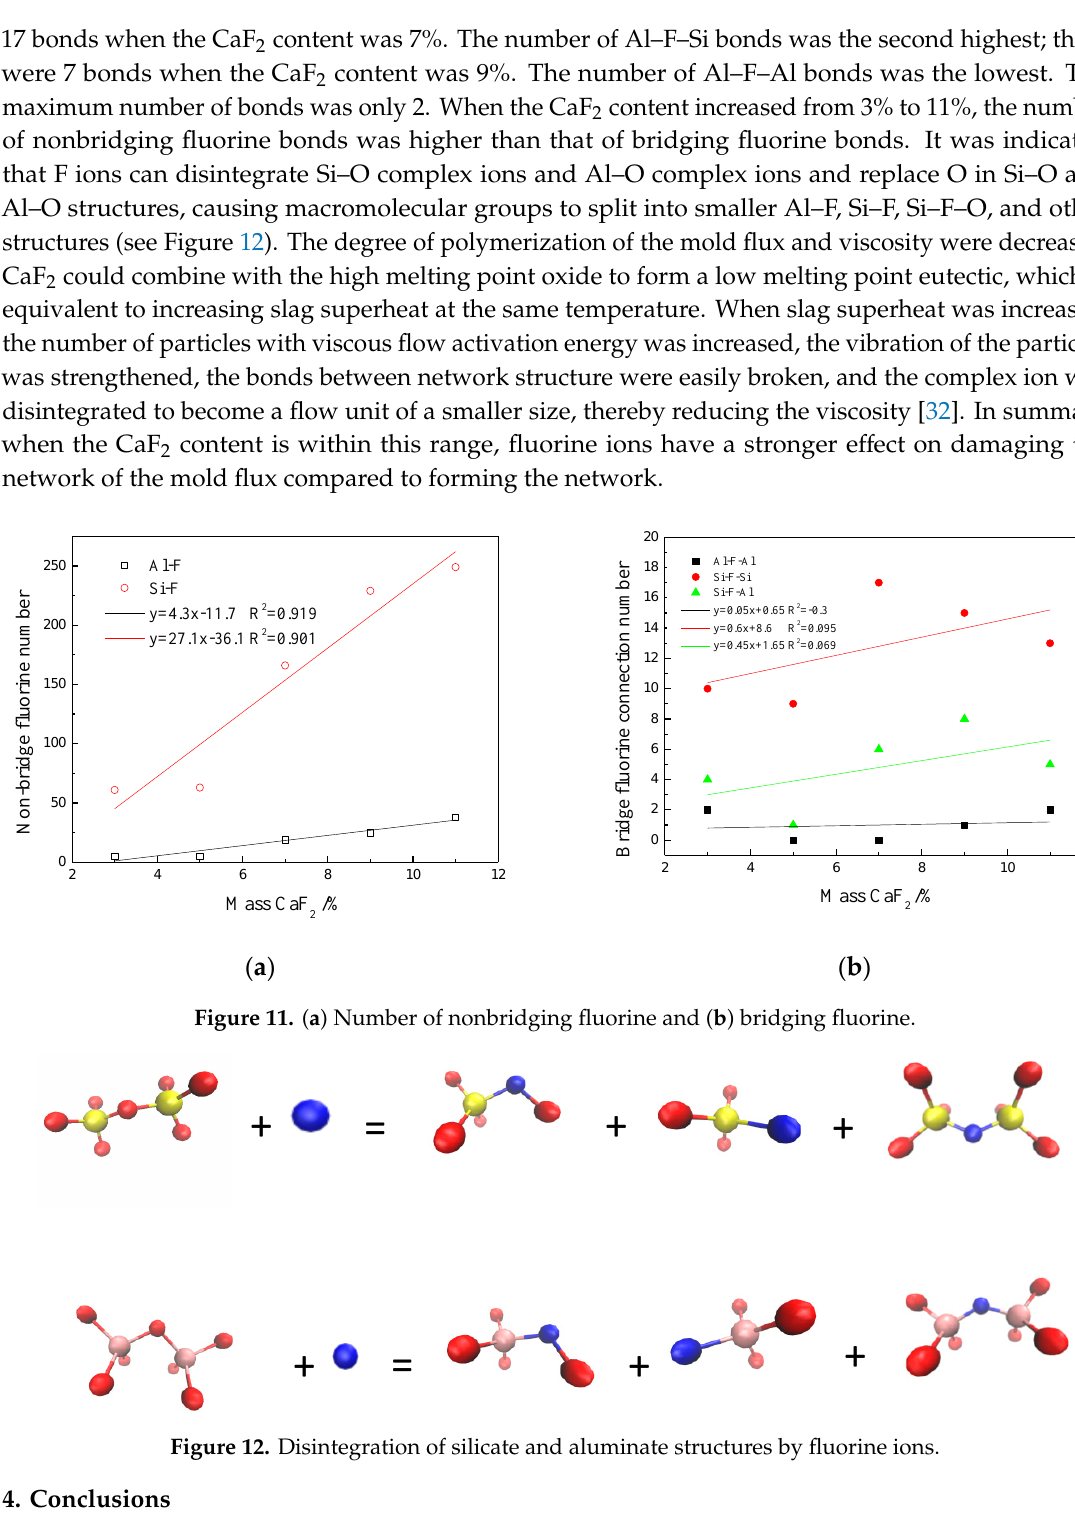
Figure 12. Disintegration of silicate and aluminate structures by fluorine ions.